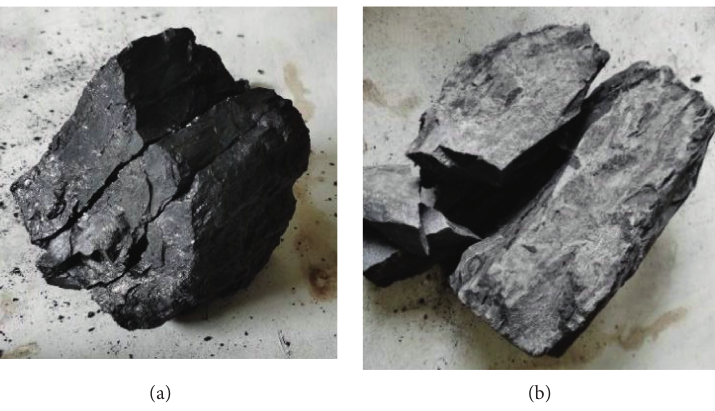
Figure 13: The phenomenon of coal gangue particle damage.